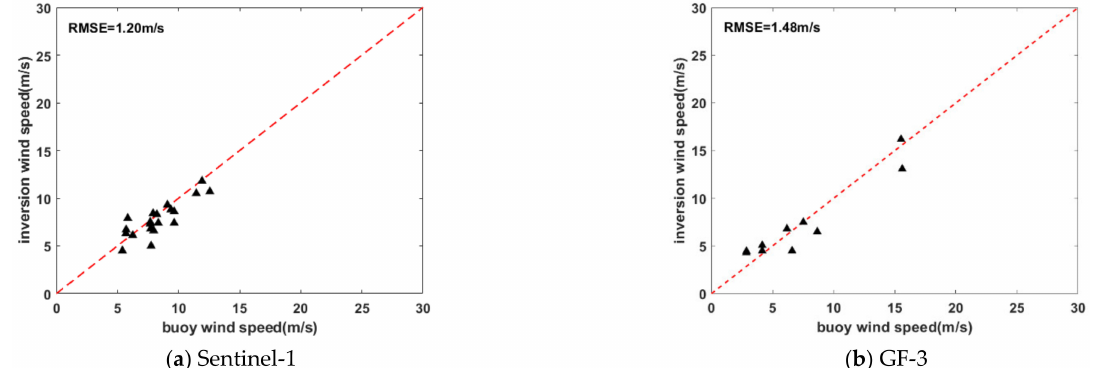
Figure 8. Comparison of inversion results with buoy